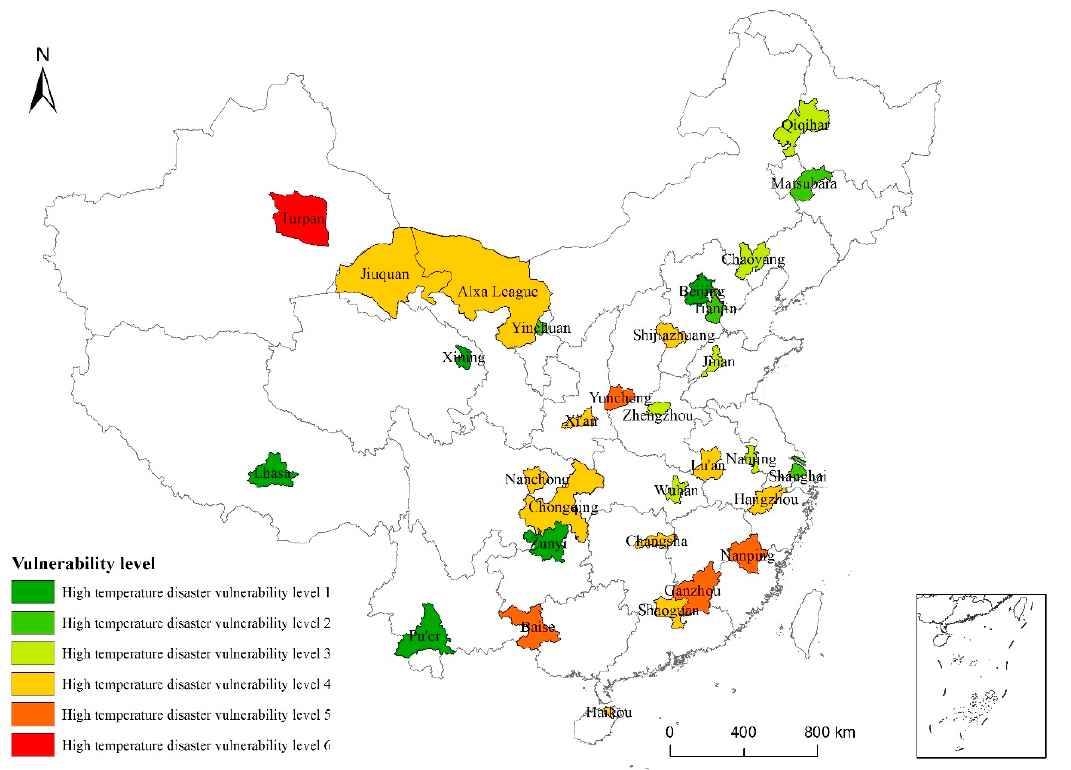
Figure 6. High-temperature vulnerability levels of 31 typical cities across China based on data from 1986 to 2015.